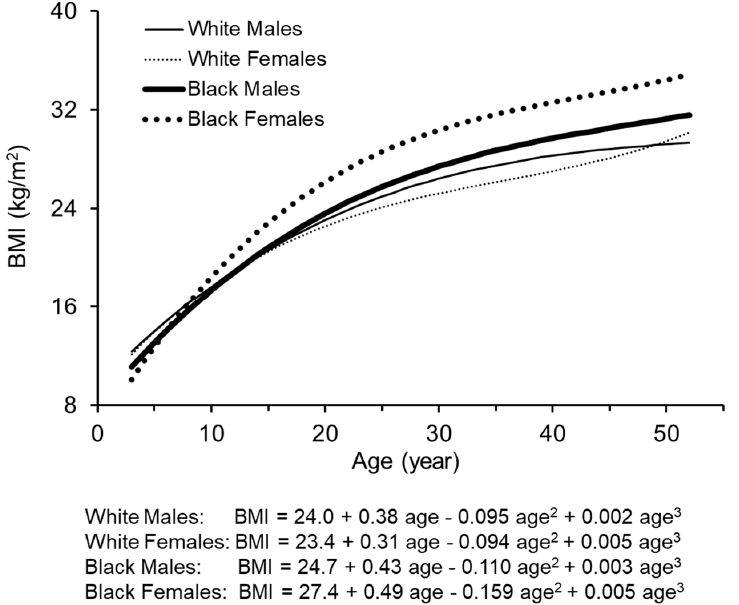
Figure 1. Growth curves of body mass index (BMI) by race and sex.